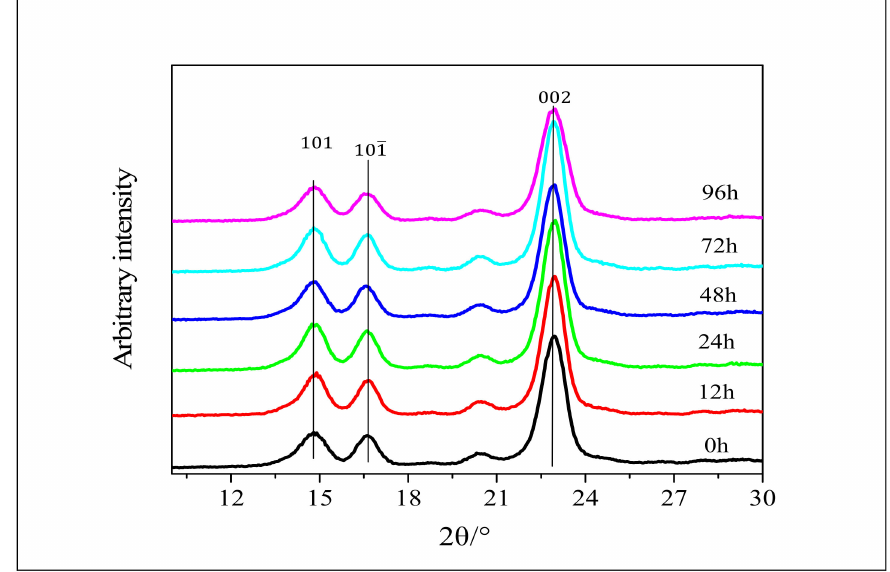
Figure 6. The XRD pattern of tunicate cellulose after enzymatic